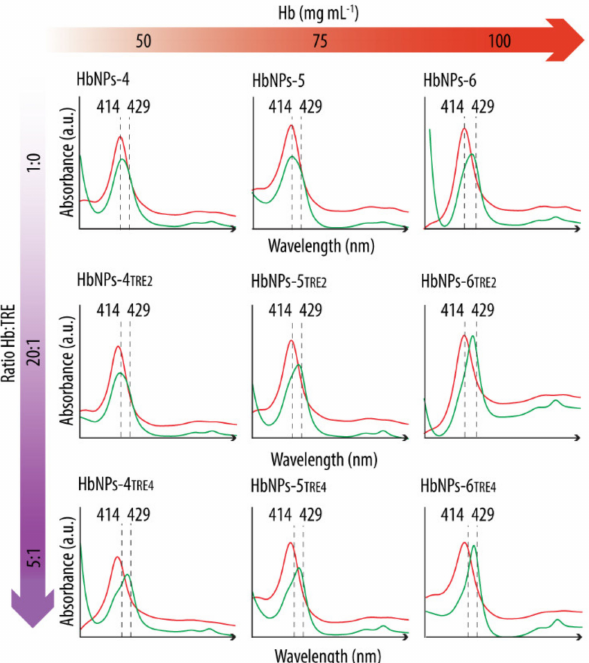
Figure 2. UV-vis spectra before (red line) and after (green line) purging with nitrogen gas HbNPs fabricated without and with the addition of trehalose (TRE) at a Hb:TRE ratio of 20:1 or 5:1. Several concentrations of Hb were considered to fabricate the HbNPs (i.e., 50, 75, and 100 mg mL − 1 Hb). The HbNPs were prepared using 12.5 mg mL − 1 PLGA and 1%